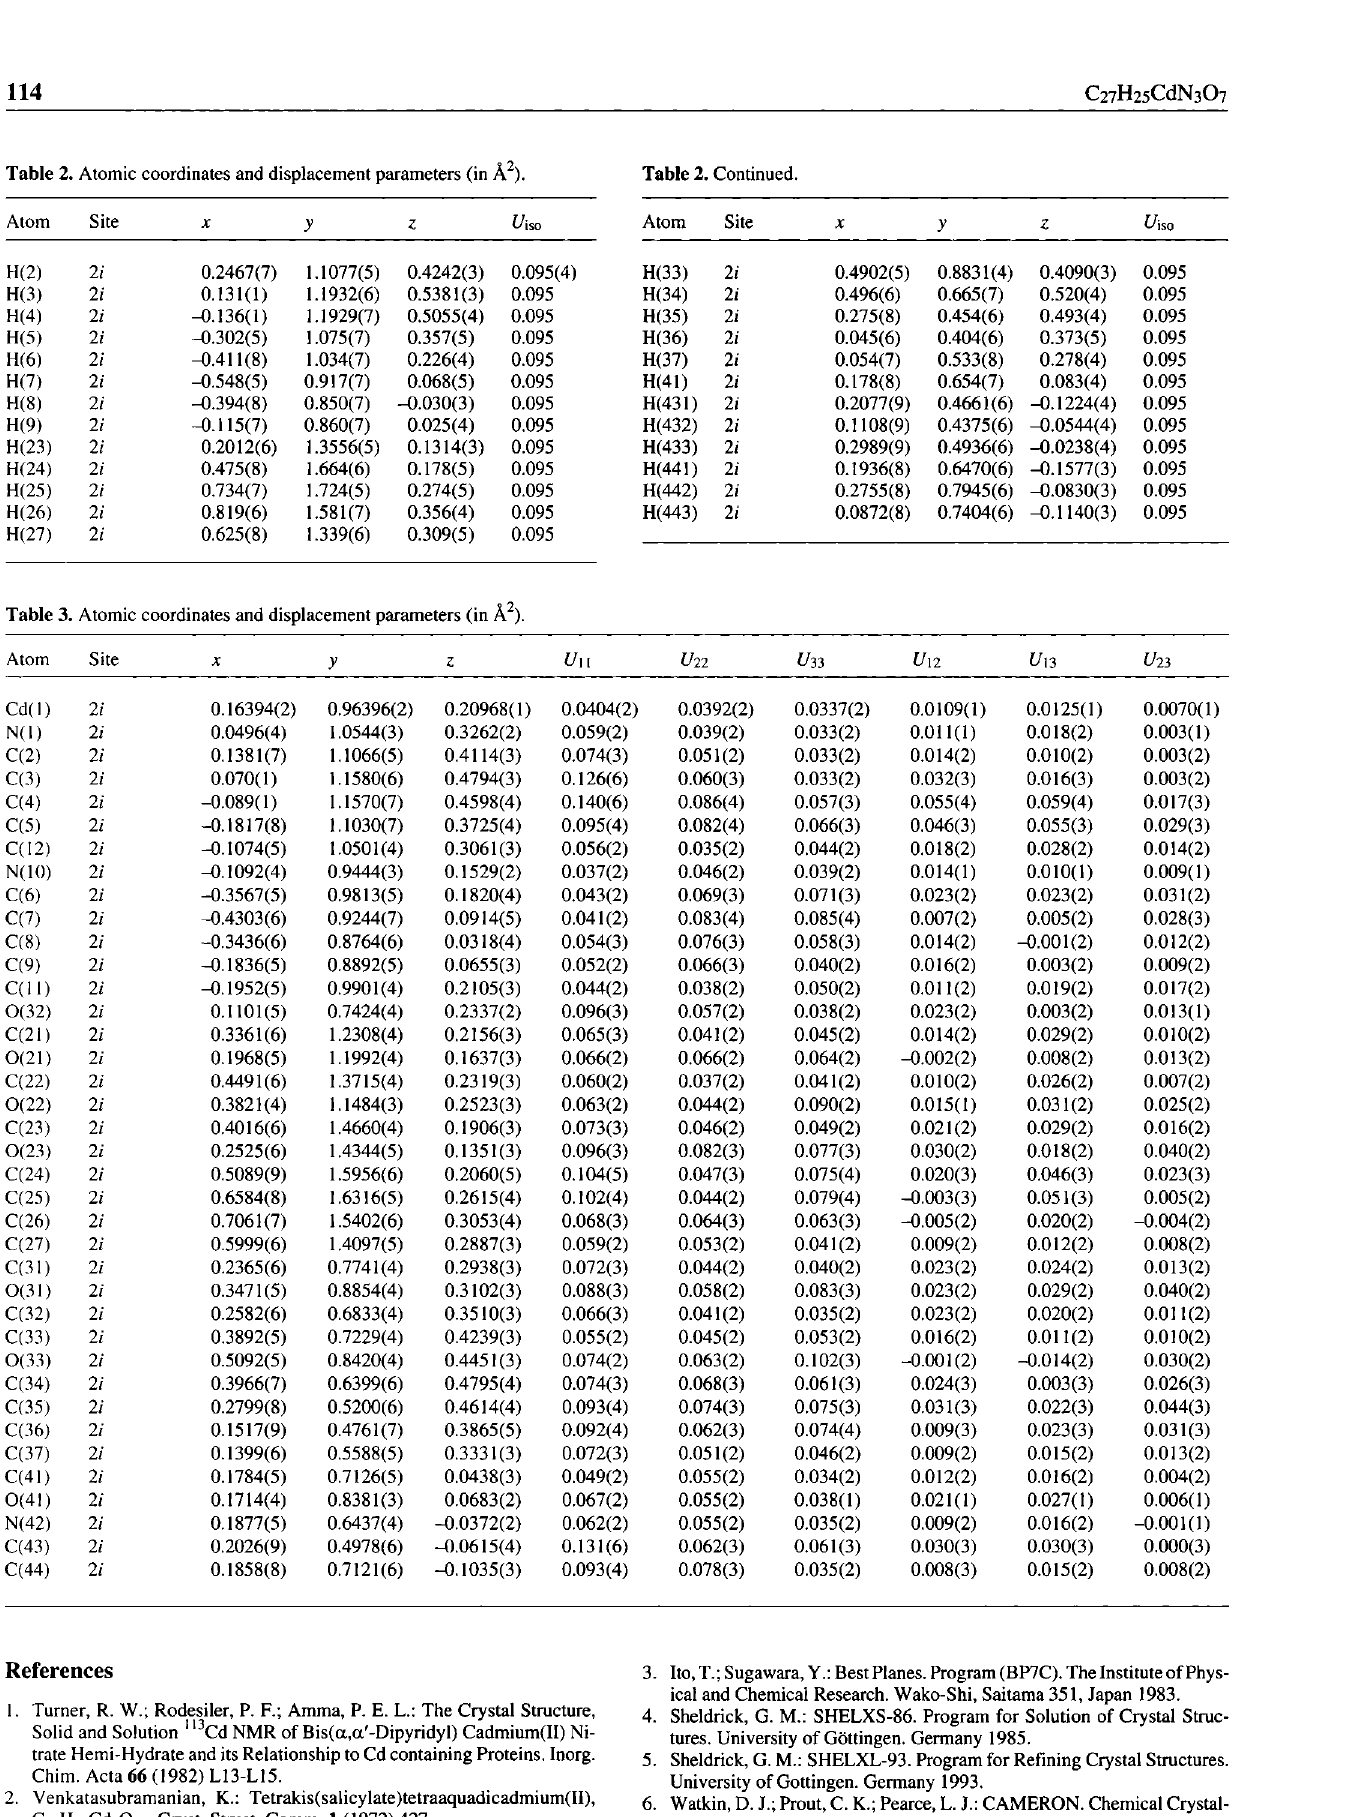
Table 2. Atomic coordinates and displacement parameters (in Ä 2 ). Table 2. Continued.